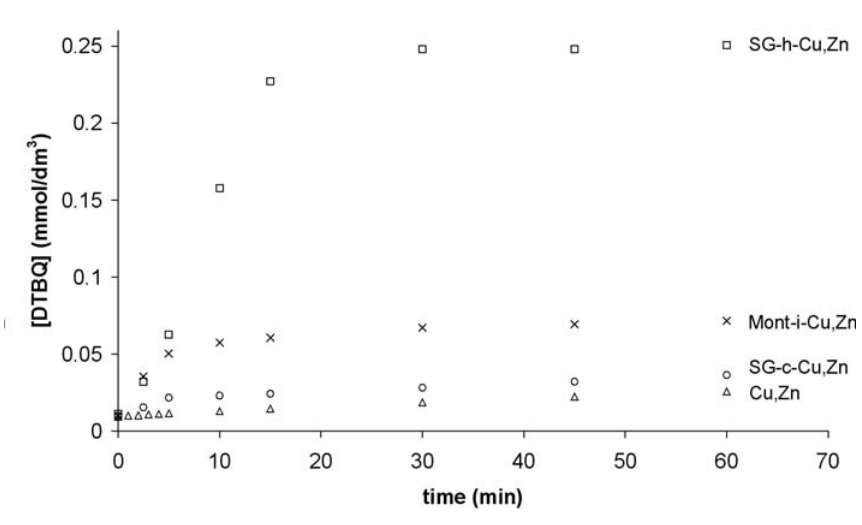
Table 1 Initial rates of DTBC oxidation catalysed by the host–free and immobilised complexes (SG–h–. . . = immobilisation on silica gel via hydrogen bonding, SG–c–. . . = immobilisation on silica gel via covalent links, Mont–i–. . . = immobilisation in montmo- rillonite by ion exchange; the reaction mixture always contained the same amount of Cu 2+ ).